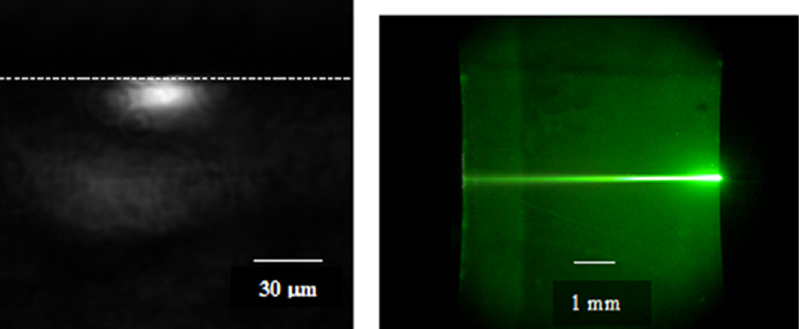
Figure 15. ( Left ): channel waveguide near field image taken at 633 nm. ( Right ): Green upconversion at 980 nm observed in the same waveguide. The channel waveguide is fabricated with N 3+ ion at E = 1.5 MeV and F = 1 · 10 16 ions/cm 2 [38].